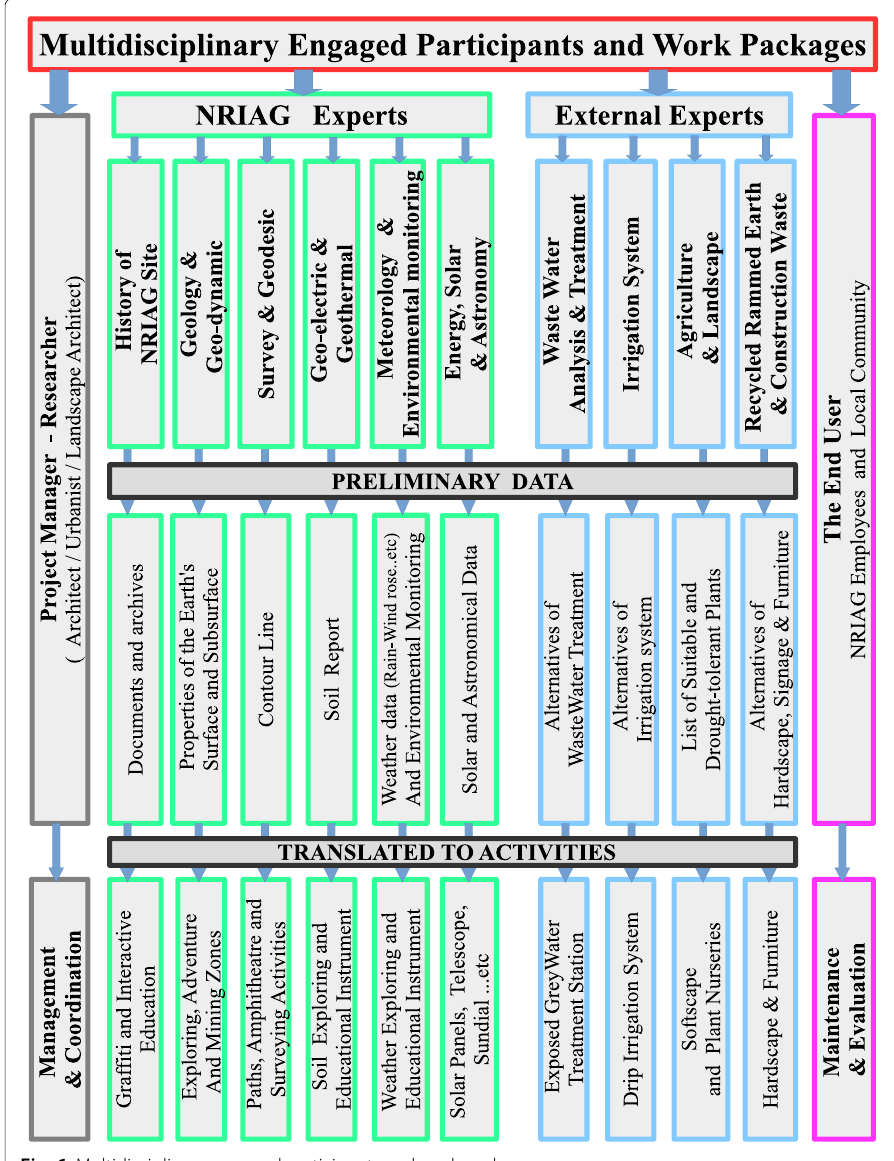
Fig. 6 Multidisciplinary engaged participants and work